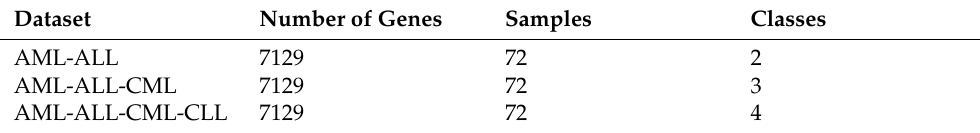
Table 2. Detail description of the leukemia